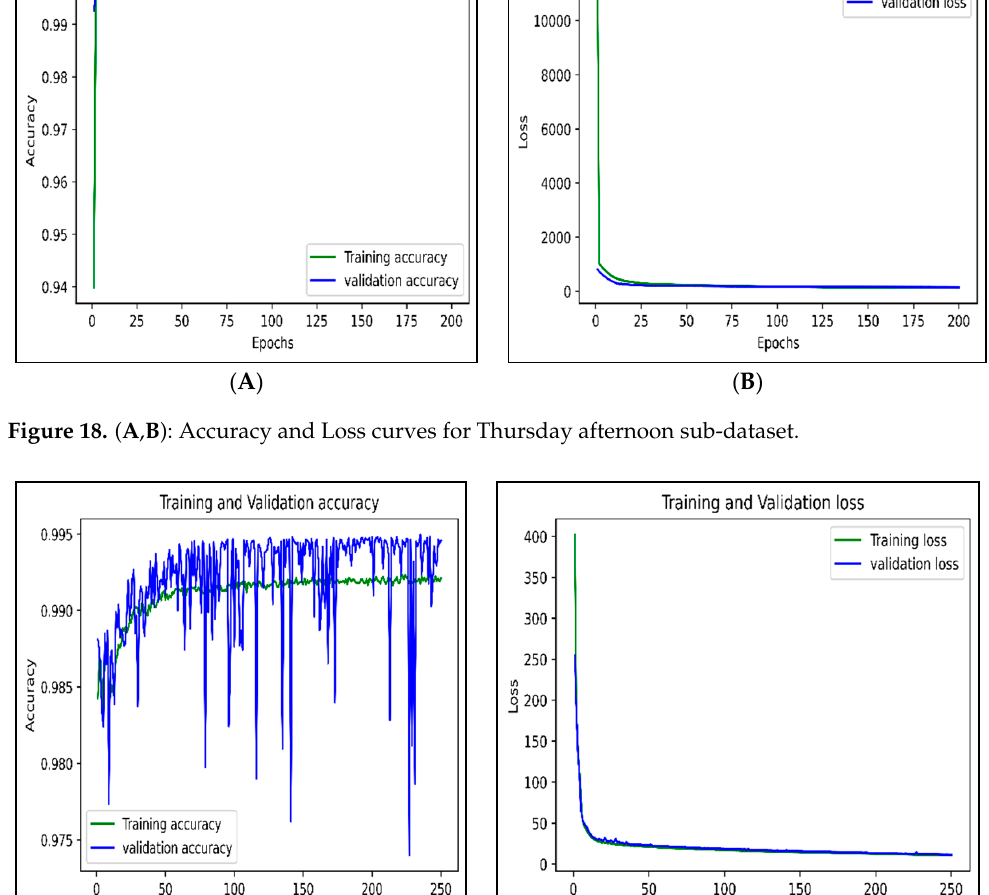
( B ) Figure 20. ( A,B ): Accuracy and Loss curves for Friday afternoon-DDoS sub-dataset. In this study, as shown in Figures 15–21, we have used a different number of epochs to gain maximum accuracy and minimum loss for each sub-dataset. The loss represents the incorrect prediction of the labels by the model. We applied the Sparse Categorical Cross-Entropy method to calculate the loss in our proposed model. We observed that the loss curve, as well as the accuracy curve, started flatten after the 100th epoch for most of the sub-datasets. After the 100th epoch, there was very little decrement and increment in loss and accuracy values, respectively.